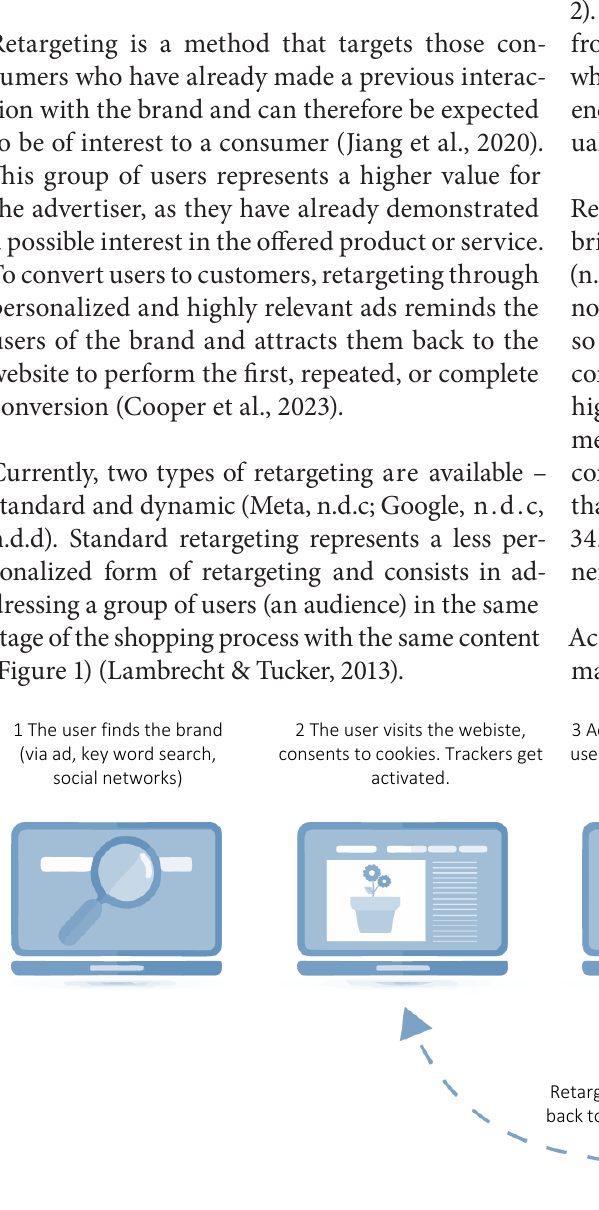
Figure 1. Standard retargeting mechanism in